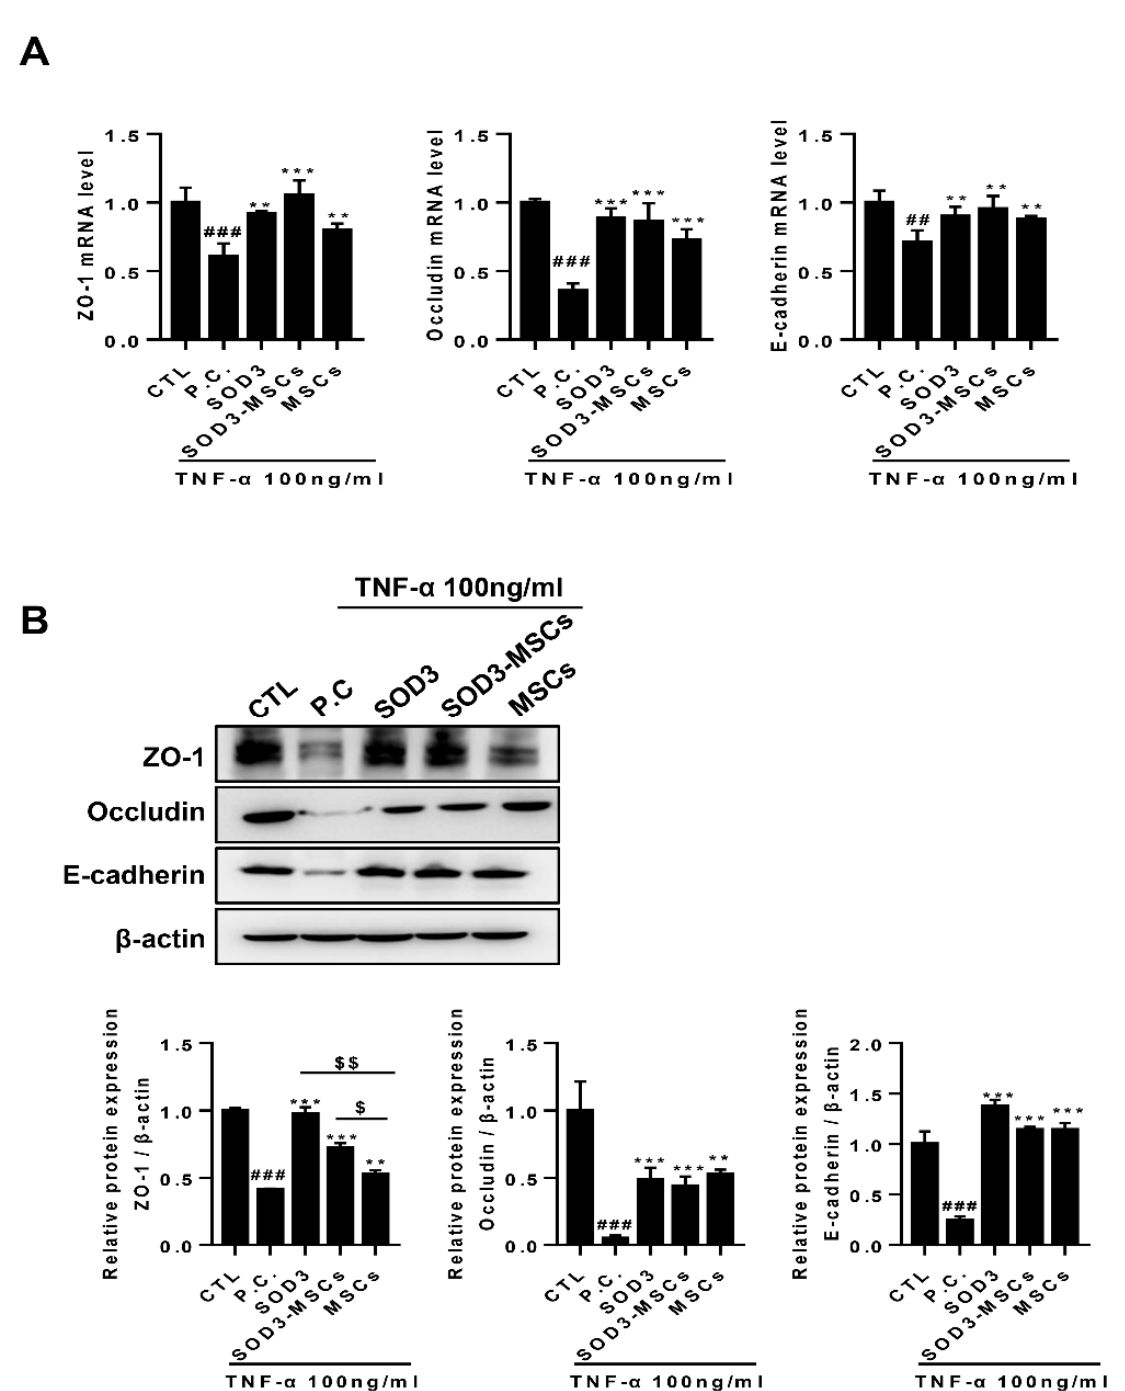
Figure 2. Protective effect of SOD3 in junctional damage of Caco-2 cells. ( A ) RNA was isolated from Caco-2 cells treated or co-cultured with SOD3 or SOD3-carrying MSCs, respectively, and the expression of tight/adherence junction markers (ZO-1, occluding and E-cadherin) was detected by quantitative PCR. ( B ) Proteins were harvested from cells of equal experimental settings and the expression of ZO-1, occludin, and E-cadherin was determined by western blotting. ## p < 0.01, ### p < 0.001 (CTL vs. P.C), ** p < 0.01, *** p < 0.001 (P.C vs. SOD3, SOD3-MSCs and MSCs), $ p < 0.05, $$ p < 0.01 (SOD3, SOD3-MSCs vs. MSCs). Results are shown as mean ± SD. Results show one representative experiment of at least three independent experiments.